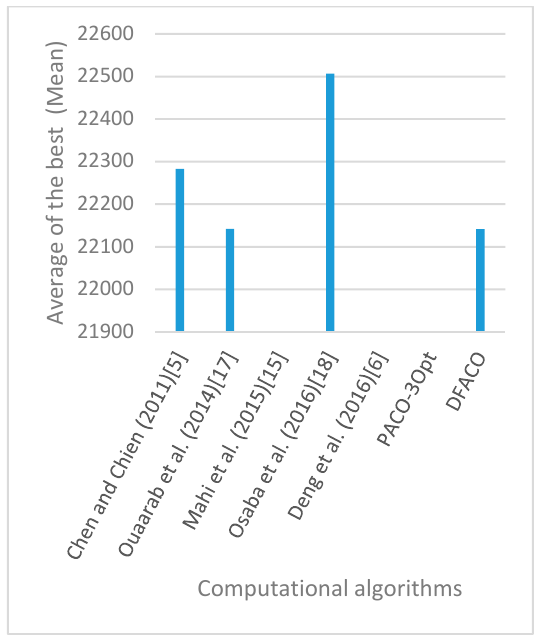
Figure 21. Average of best solutions obtained for instance kroB100 by all algorithms.